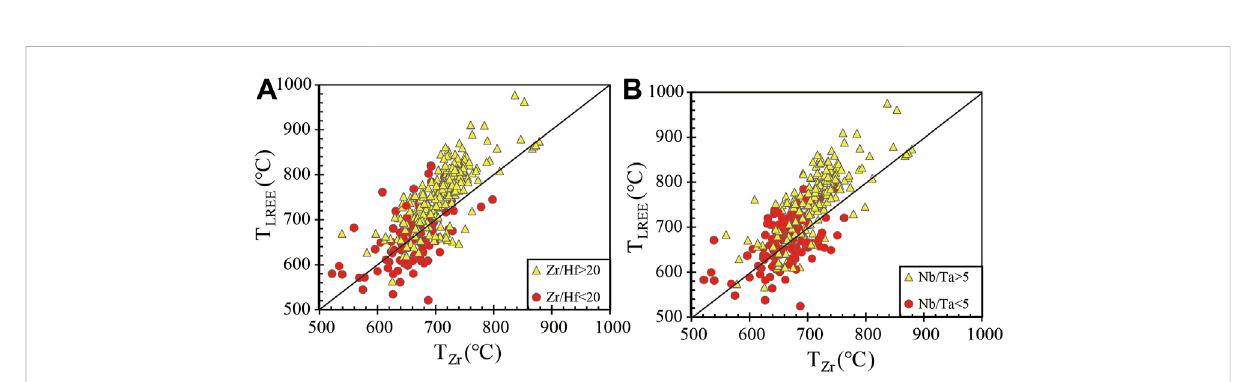
FIGURE 6 Zircon saturation thermometry T Zr vs monazite saturation thermometry T LREE in the high-silica magmas.